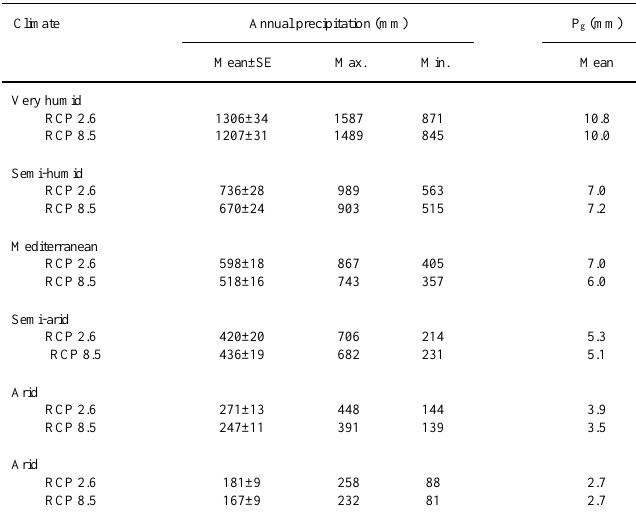
Table 5. Projections of annual precipitation, and mean storm magnitude (P g ) during the period of 2020-2050 predicted by the GCM under RCP 2.6 (low emission), and RCP 8.5 (high emission) scenarios. SE: standard error of mean of mean Climate Annual precipitation (mm) P g (mm) Mean±SE Max.